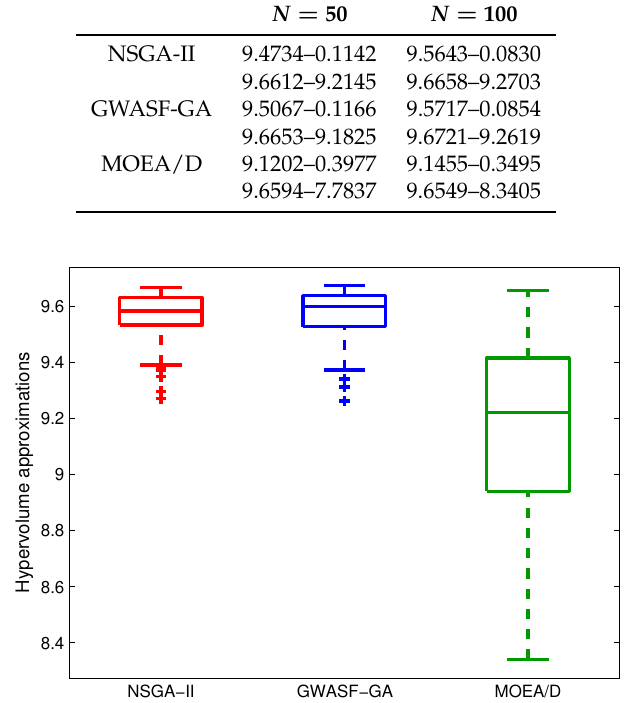
Table 1. Comparison and statistical results of the mean, standard deviation values (upper), and the best and worst hypervolume values (lower), respectively, for NSGA-II, GWASF-GA and MOEA/D, over 100 runs.